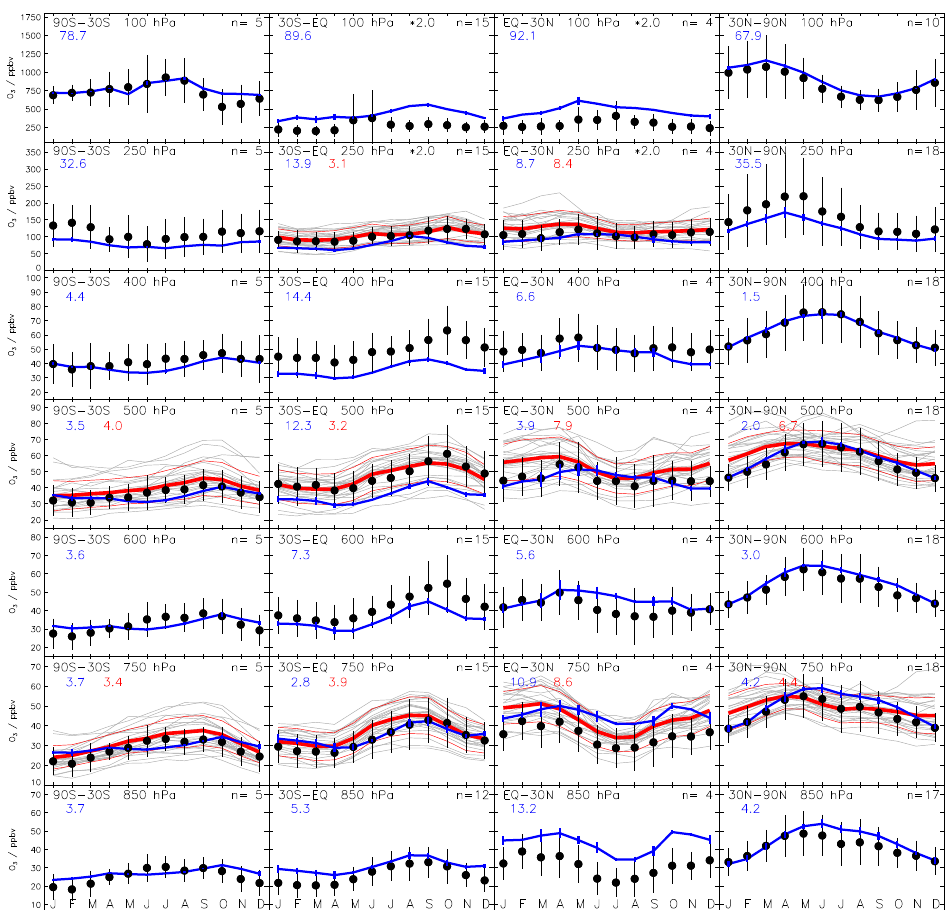
Fig. 29. Comparison of the annual cycle of O 3 observations (black) with UKCA TropIsop (blue), the ACCENT ensemble of models (grey) and the ACCENT multi-model ensemble mean (red). Observations are taken from Logan et al. (1999) and Thompson et al. (2003a, b). The modelled and observed O 3 concentrations at 100 and 250hPa in the latitude bands 30 ◦ S–EQ and EQ–30 ◦ N have been multiplied by a factor of 2. The root mean square error in ppbv between UKCA TropIsop and the observations is included in blue and the root mean square error in ppbv between the ACCENT multi-model mean and the observations is included in red.